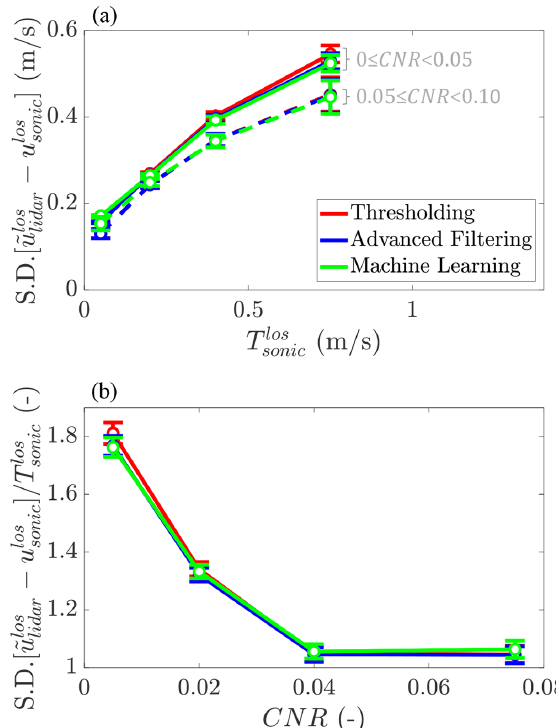
Figure 11. Convergence of the standard deviation, SD, of error with the (a) magnitude of time-local turbulent fluctuations, T los (b) carrier-to-noise ratio, CNR, for inflow cases without solid in- terference across the four higher comparison heights. T los running standard deviation of velocity from the sonic anemome- ter along the line of sight based on the filtering window described in Sect. 2.4.2. The CNR values are calculated from the advanced filtering technique’s output spectra as described in Sect. 2.3. Data plotted derive from all the comparison heights except the bottom z = 10 . 1m